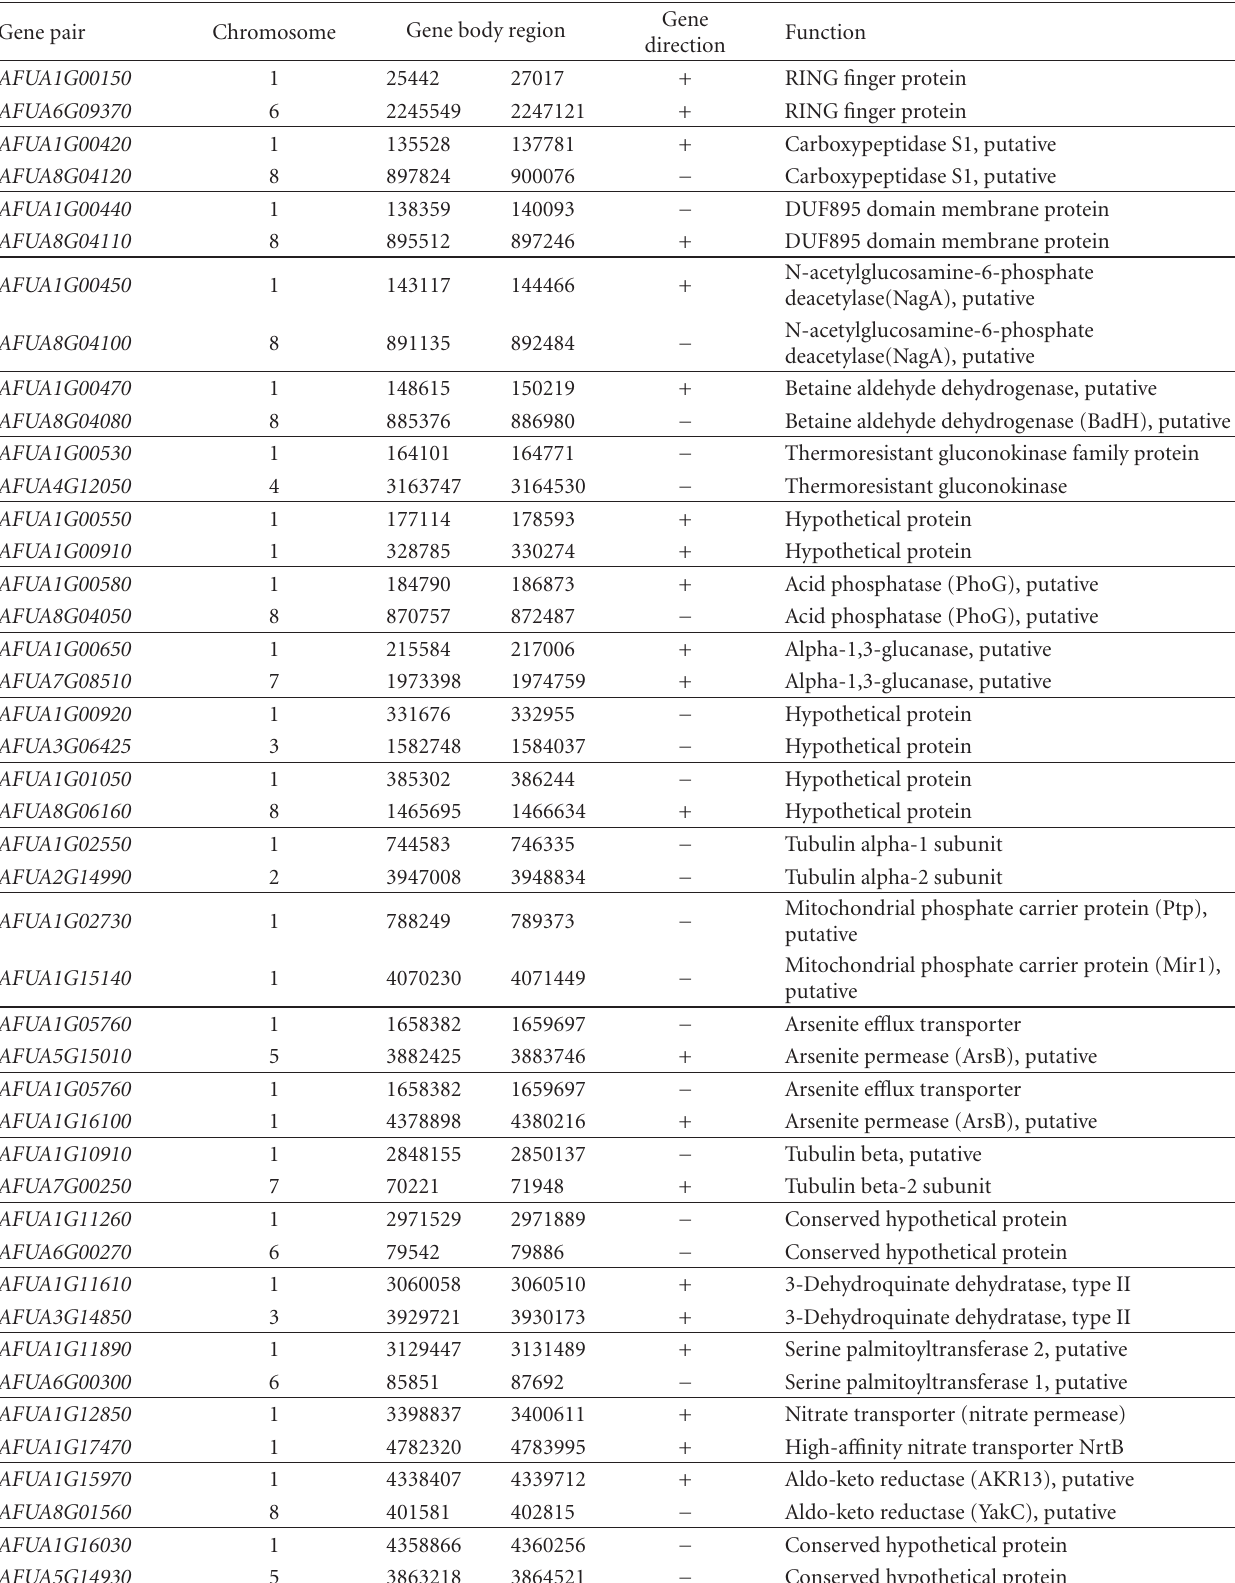
Table 1: Duplicated gene pairs in Aspergillus fumigatus